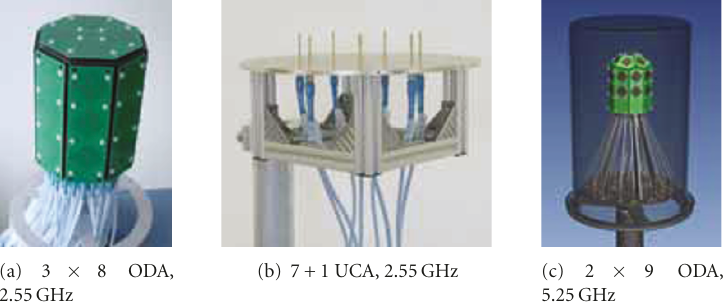
Figure 10: Antenna arrays. (a) 2.55 GHz omni-directional patch array (ODA), (b) 2.55 GHz circular monopole array (UCA), (c) 5.25 GHz ODA.